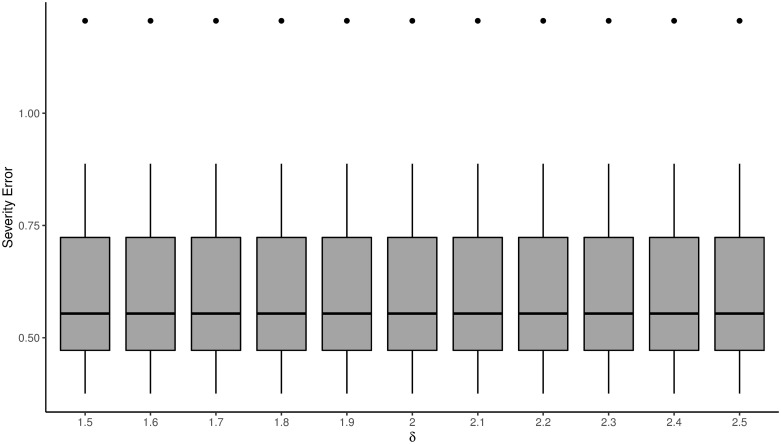
Parameter estimation errors of the D-FSBoost model when varying the value of δ from 1.5 to 2.5.